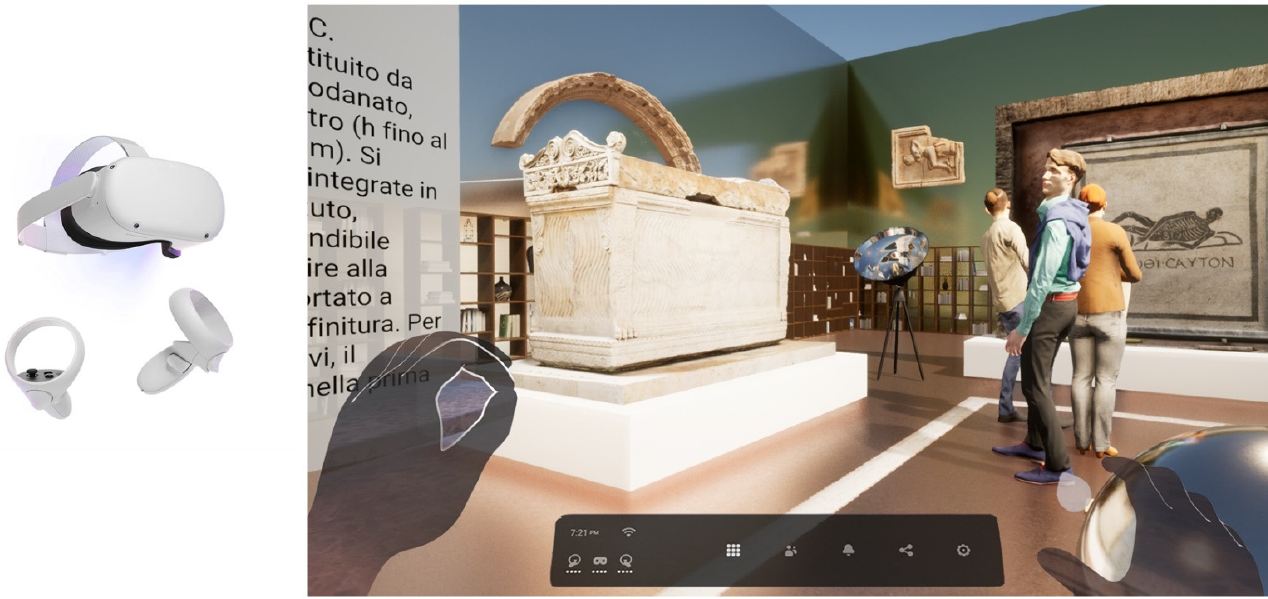
Figure 9. Meta Quest 2 and the VR controllers interact with the VR environment and its multimedia contents.